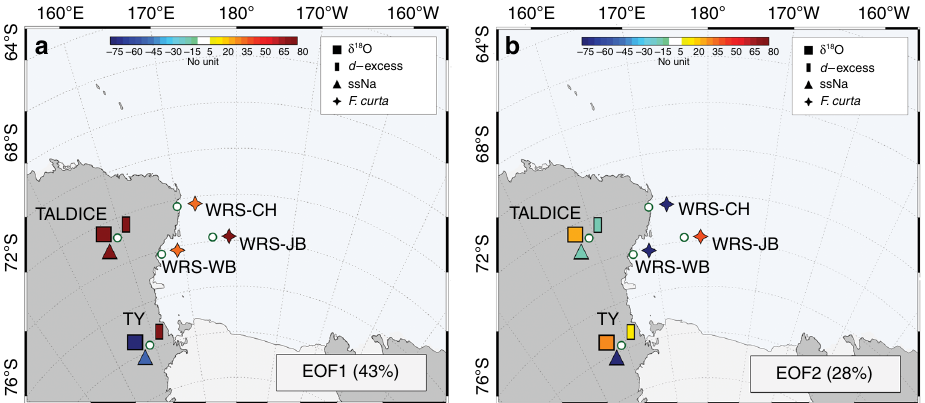
Fig. 5 Empirical orthogonal function analysis of ice and marine records. Least square empirical orthogonal function analysis applied to a covariance matrix based on standardized values of δ 18 O ( fi lled square), deuterium excess ( d -excess, fi lled rectangle) and sea salt sodium (ssNa, fi lled triangle), obtained from TALDICE and Taylor Dome (TY) ice core data, and, F. curta ( fi lled star) obtained from Cape Hallett (WRS_CH), Joides Basin (WRS_JB) and Wood Bay (WRS_WB) marine core data. The colour code shows the strength of the component values of EOF1 and EOF2 ( a and b , respectively) for each proxy data used in the calculation. The numbers in brackets represent the percentages of variance explained by EOF1 and EOF2 (43% and 28% of the total variance,